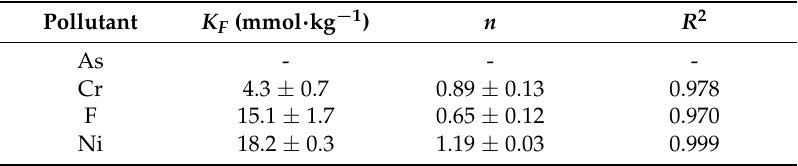
Table 3. The satisfactory fitting of Cr, F, and Ni data to the Freundlich model suggests multilayer-type adsorption on wheat straw for these elements. Table 3. Parameters of the Freundlich model related to sorption on wheat straw.